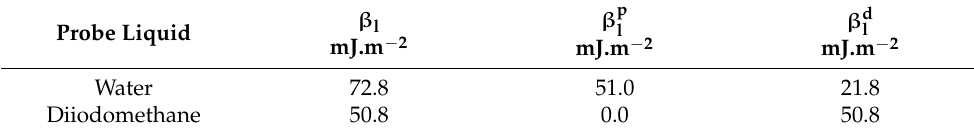
Table 1. The surface energy components of water and